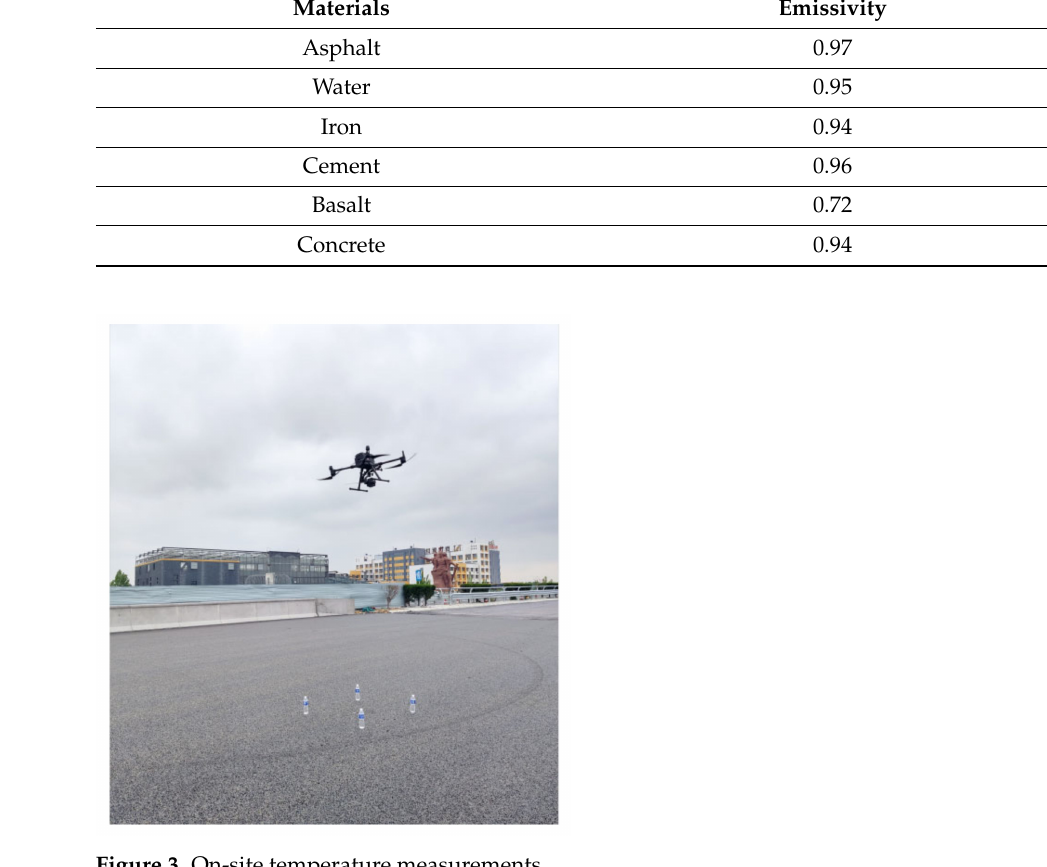
Figure 3. On-site temperature